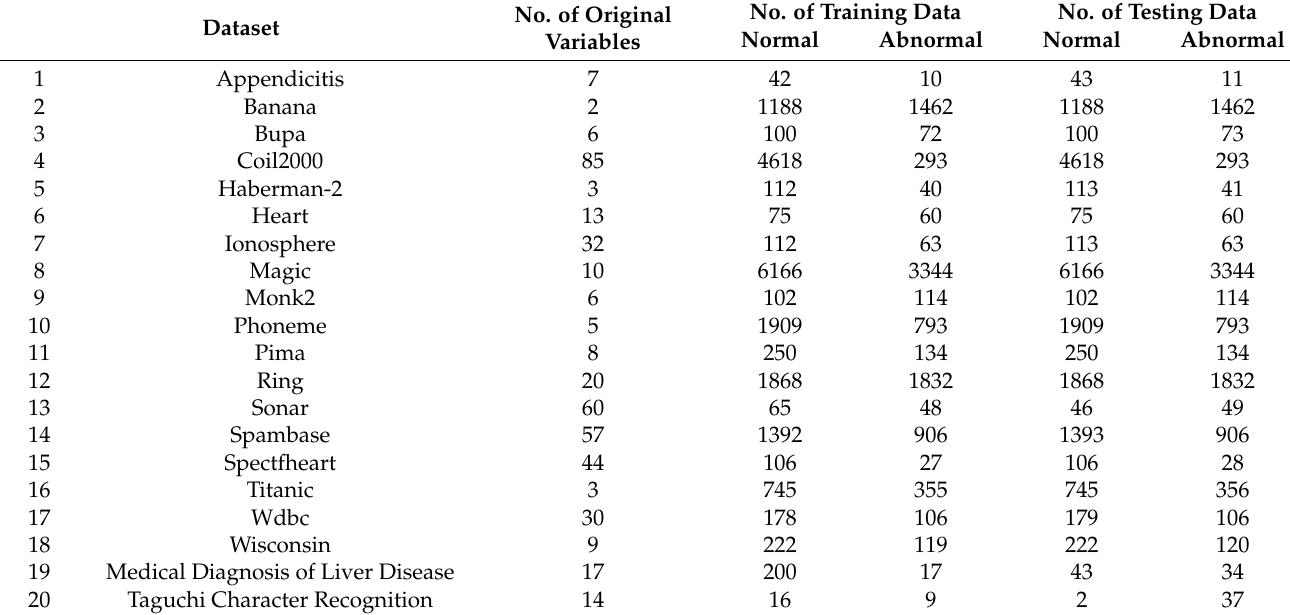
Table 5. Twenty datasets used in this study.